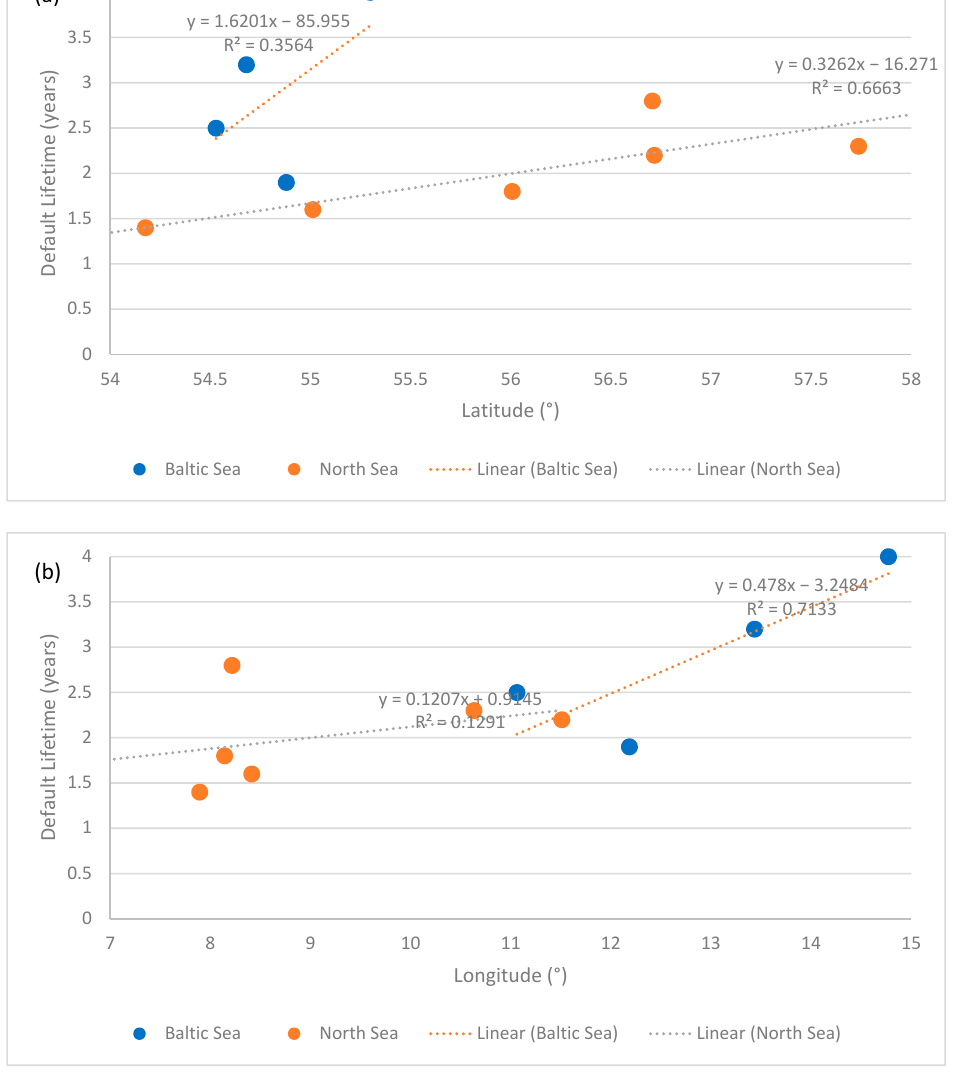
Figure 8. The default lifetime at Danish and German coastal stations along the North Sea and Baltic Sea as function of ( a ) latitude and ( b ) longitude and linear regression results. 422